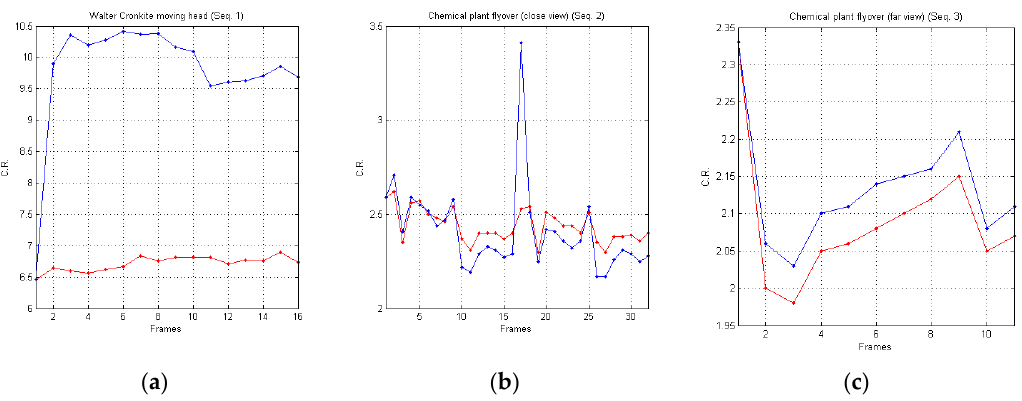
Figure 9. Graphical comparison of the achieved C.R. between the AVQ IS algorithm (blue line) and the AVQ algorithm (red line) for ( a ) Seq. 1 ; ( b ) Seq. 2 ; and ( c ) Seq. 3 .